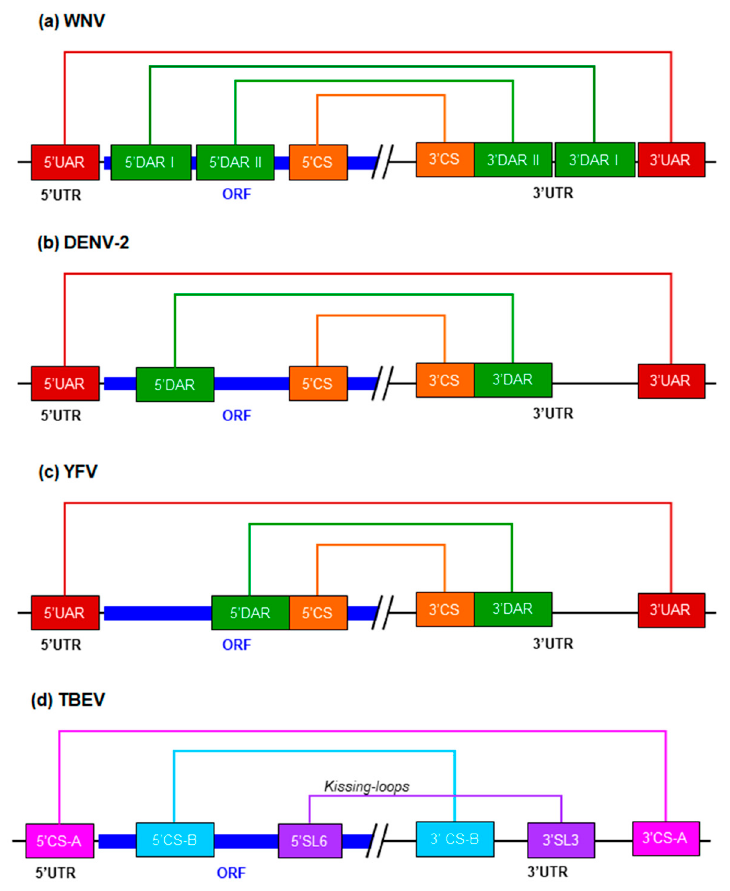
Figure 3. Long-range RNA–RNA interactions involved in the cyclization of flavivirus genomes. The diagram shows the linear form of the RNA genomes of four representative flaviviruses: ( a ) WNV; ( b ) DENV-2; ( c ) YFV; and ( d ) TBEV. Colored boxes (same key as in Figures 1 and 2) show different interacting sequences with their names. Long-range interactions are illustrated by thick colored lines. The dark blue box represents the ORF.